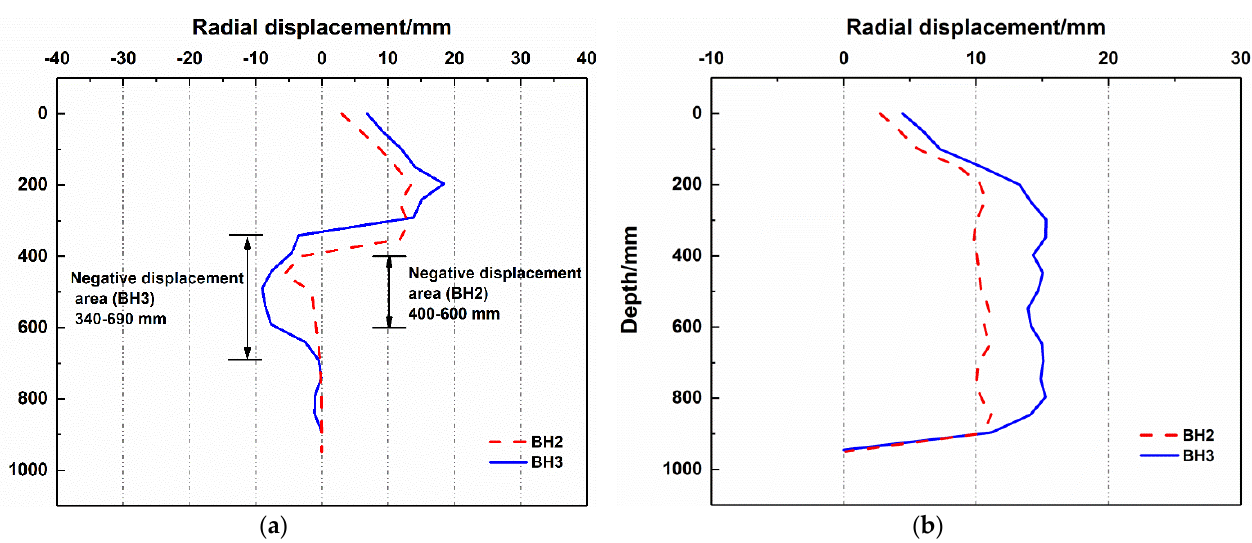
Figure 9. Radial displacement around boreholes with different drilling fluids: ( a ) water; ( b ) polymer fluids.